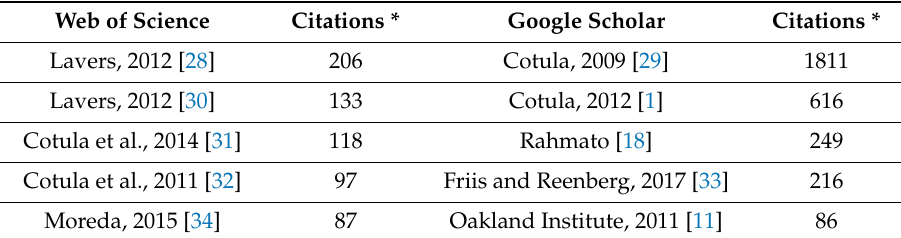
Table 2. Most cited publications in Web of Science and Google